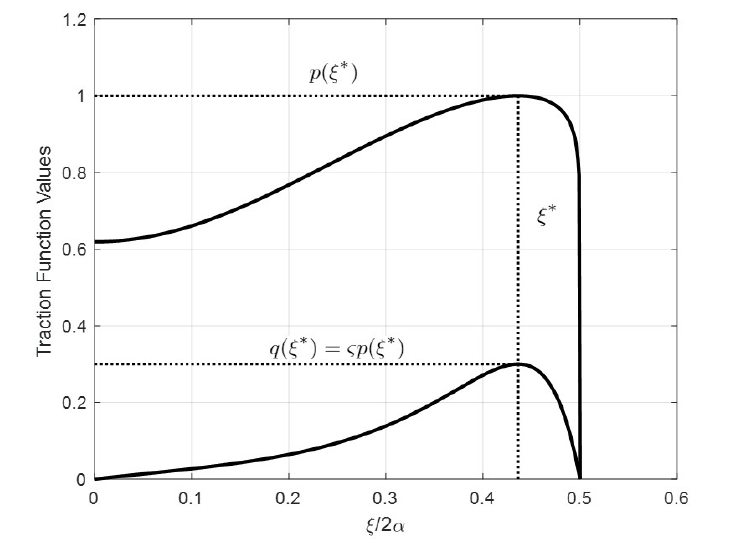
Figure 4. Example normal and shear traction curves from Equations (1) and (2),